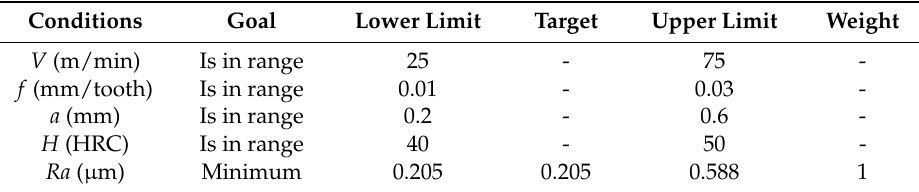
Table 6. Constrains and goals for single objective optimization.